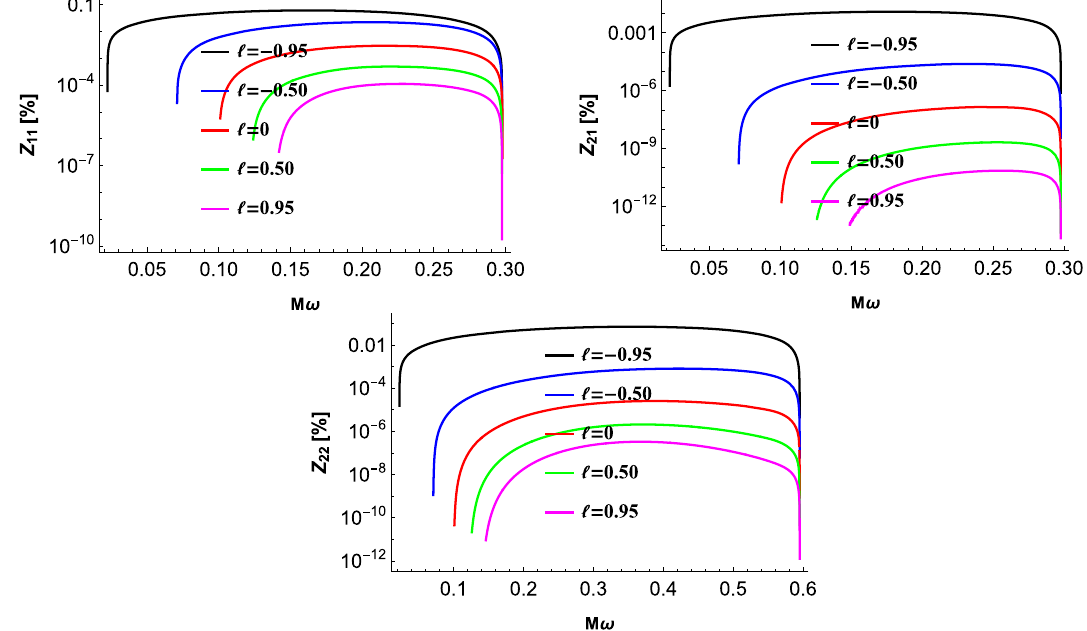
Fig. 6 Variation of amplification factors with (cid:2) for various multipoles with ˆ μ = 0 . 1 , b = 0 . 02 M 2 , and ˆ a = 0 . 55